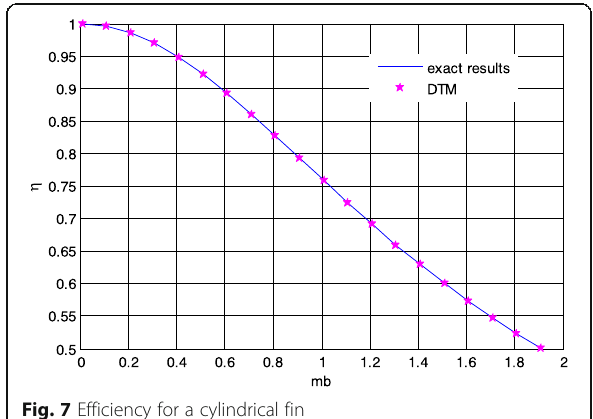
Fig. 7 Efficiency for a cylindrical fin